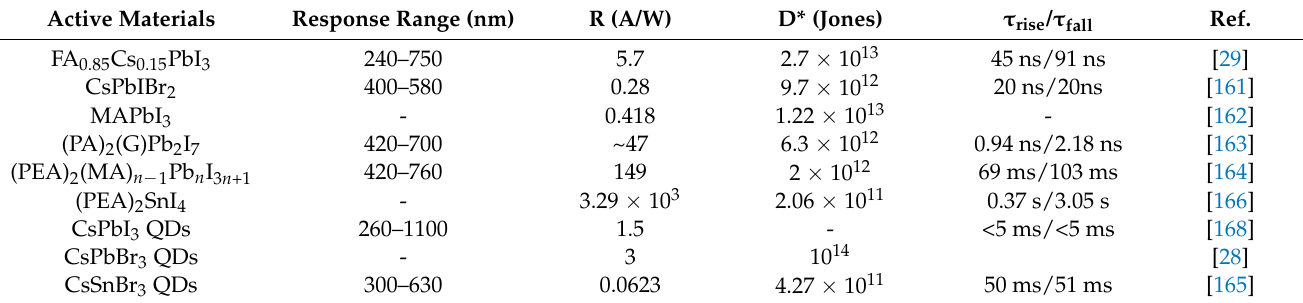
Table 4. Summarized device performance of photodetectors in Section